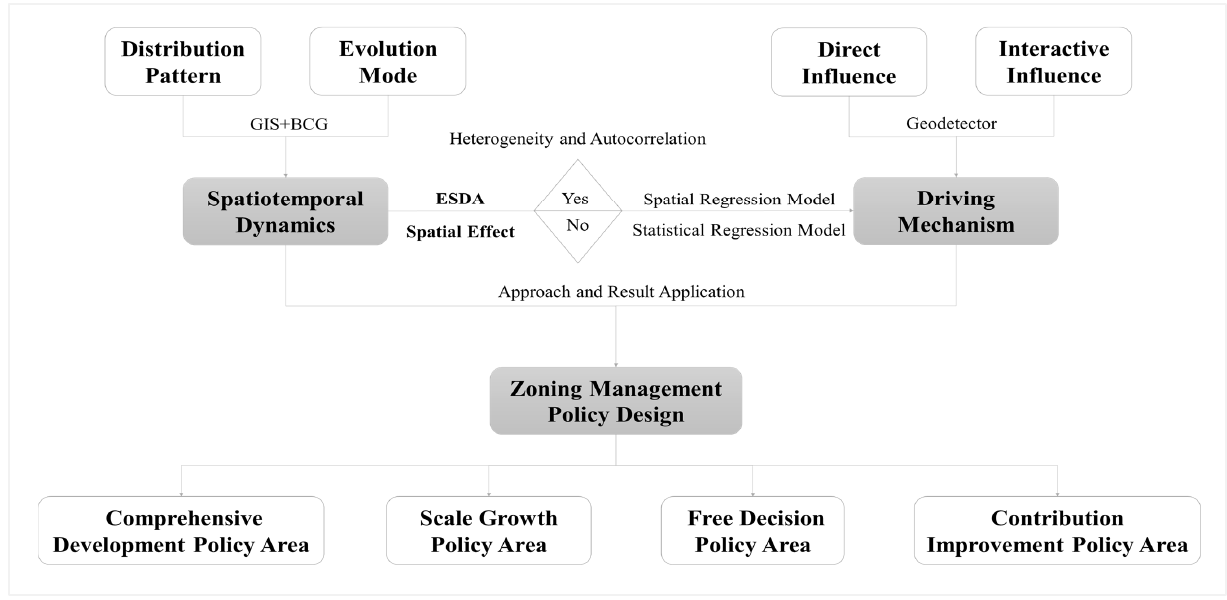
Figure 4. Research